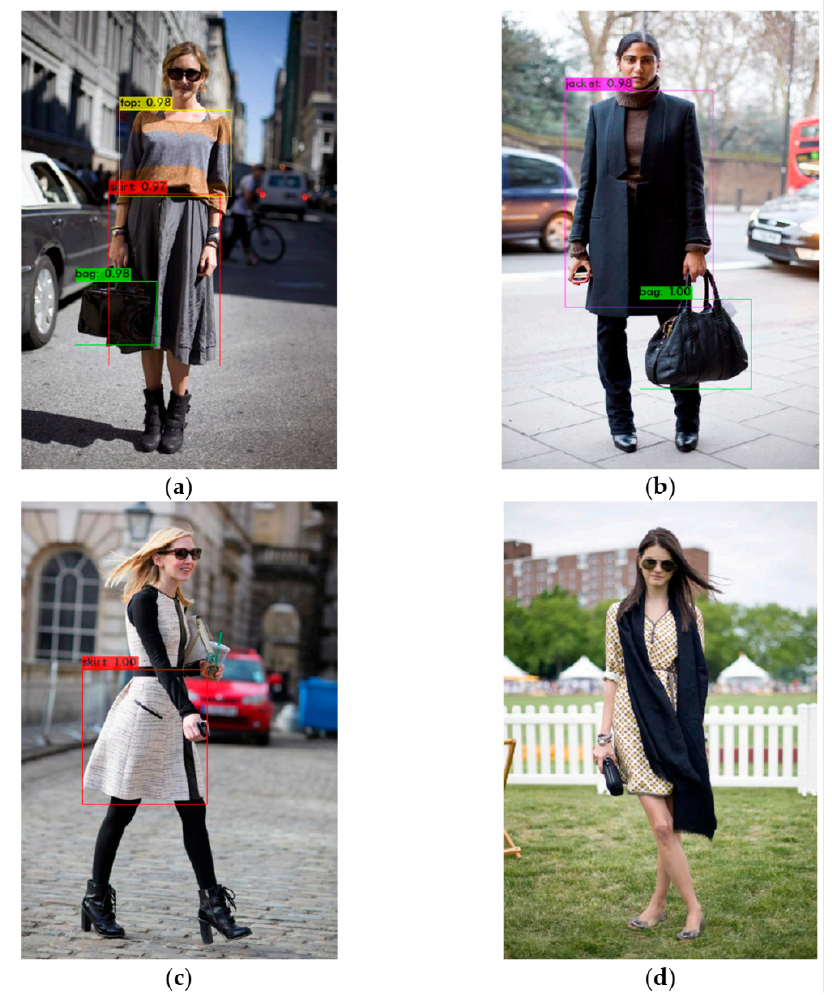
Figure 6. The result images of object detection—( a , b ) correct detection, ( c ) sideways apparel, and ( d ) object